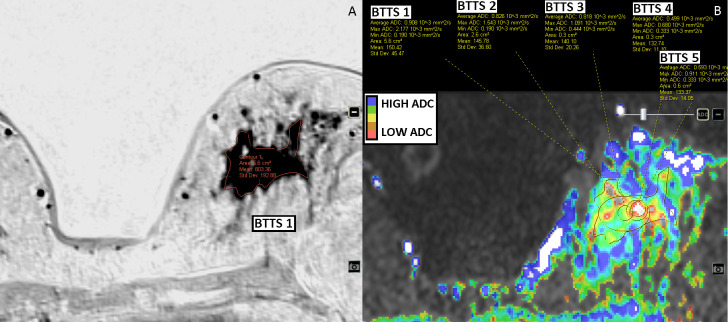
Invasive lobular carcinoma of the left breast, ER positive, PR negative and HER2-neu positive.Surrounding lobular carcinoma in situ. DCE-T1 subtracted images (inverted) (A) and DWI b0-1000 images (B).